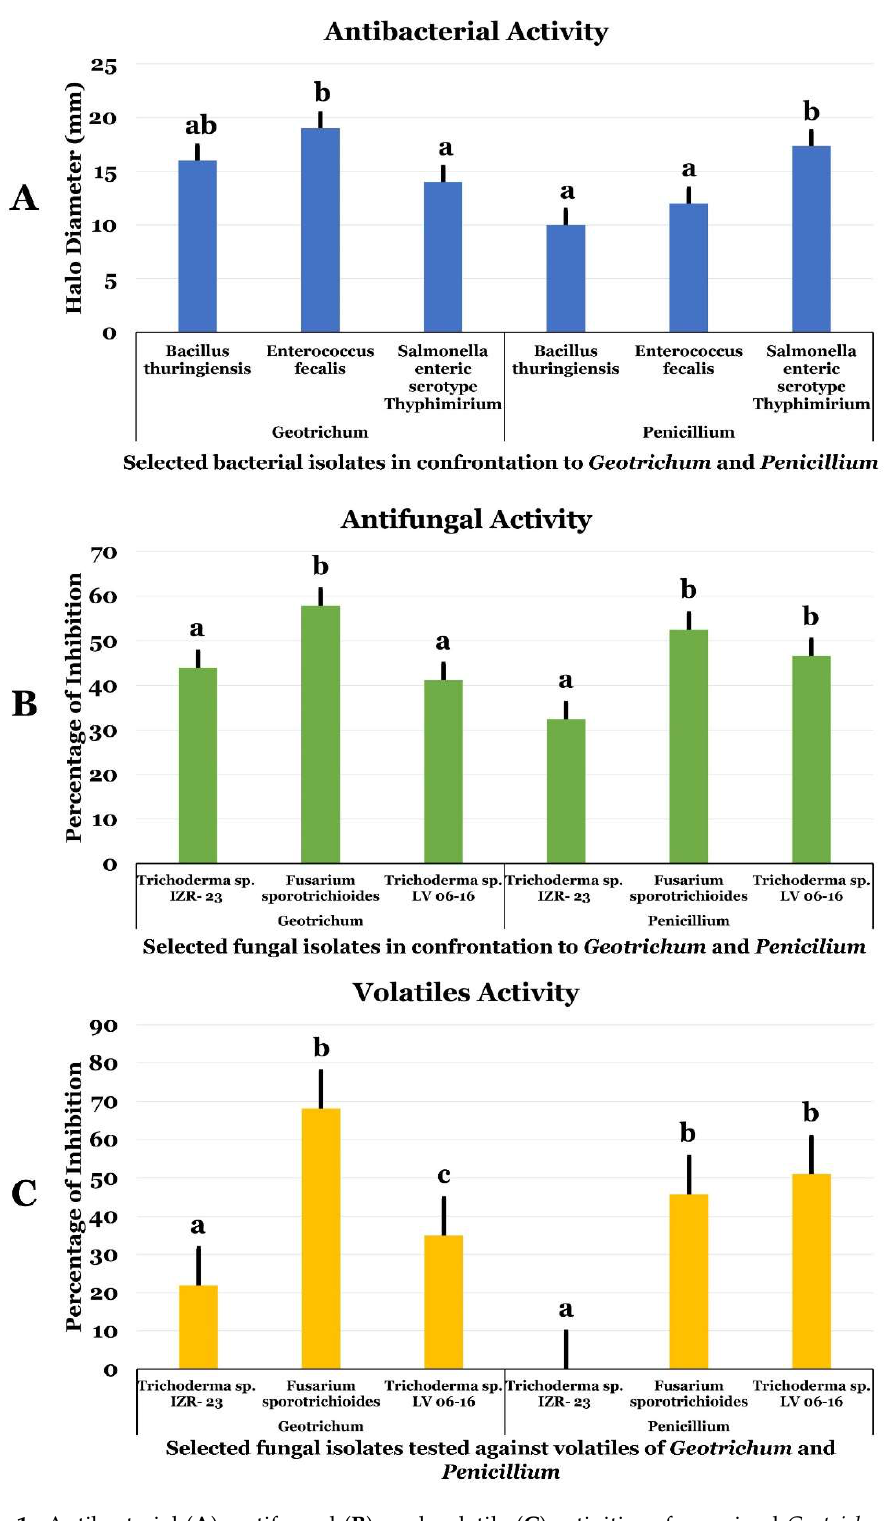
Figure 1. Antibacterial ( A ), antifungal ( B ), and volatile ( C ) activities of examined Geotrichum and Penicillium (Hex, EtOAc, MetOH, EtOH) against pathogenic bacteria and fungi. Data presents the mean ± standard error. Bars labelled with different letters are significantly different among the treatments at p < 0.05 using the Tukey’s HSD test. In each bar groups, bars labelled with the same letter are not significantly different from each other according to Tukey’s HSD at p < 0.05.